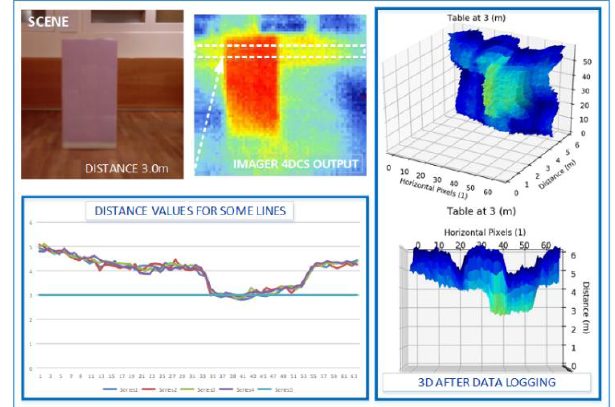
Figure 10. The depth camera (time-of-flight) module can detect objects located at a distance up to 4 m